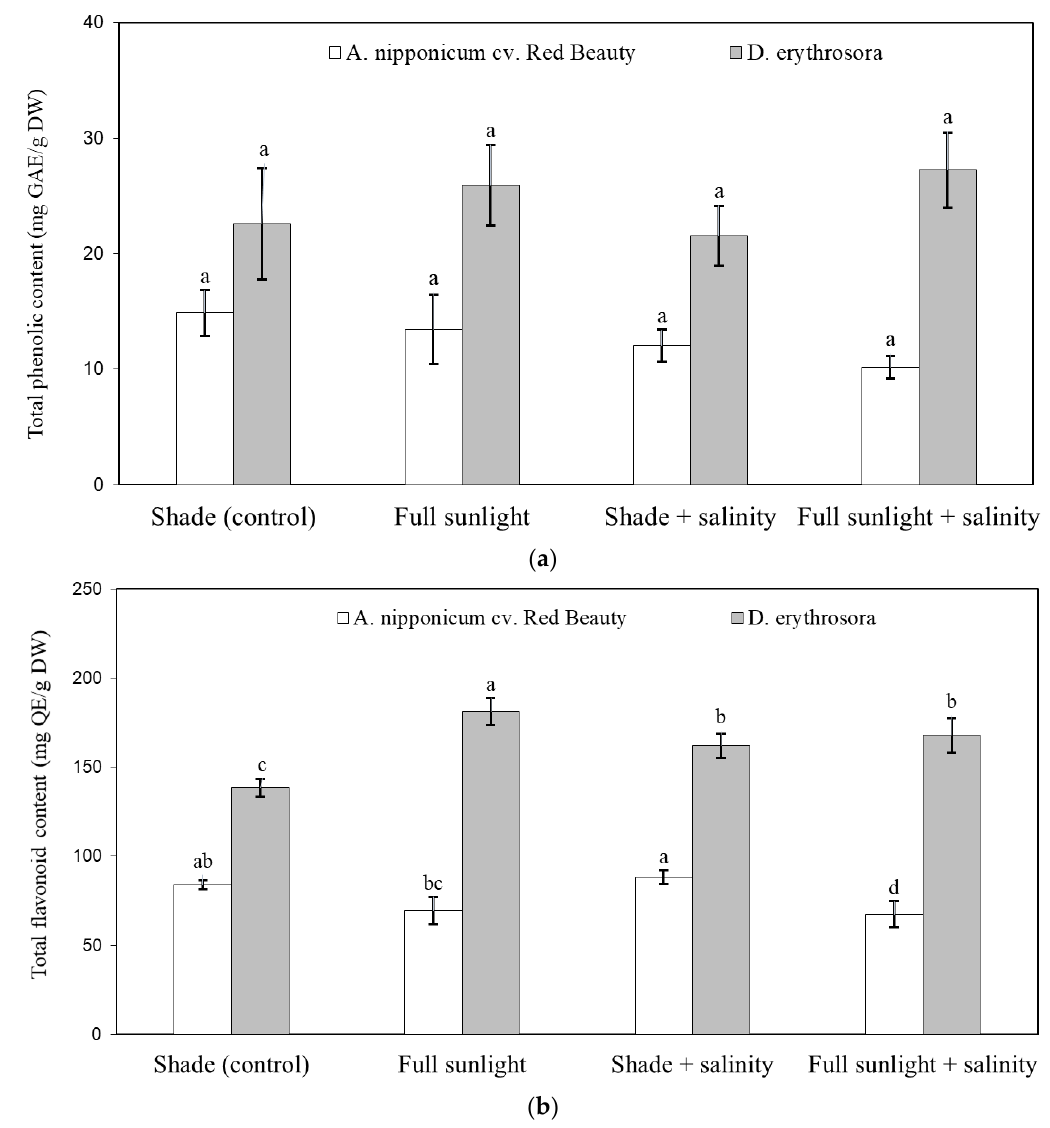
Figure 2. Effect of abiotic stresses on total phenolic content ( a ) and total flavonoid content ( b ) of two hardy ferns. Vertical error bars indicate the standard deviation of the mean. Different letters indicate a significant difference between treatments within given taxa at p ≤ 0.05 (ANOVA, Tukey’s HSD post hoc test).